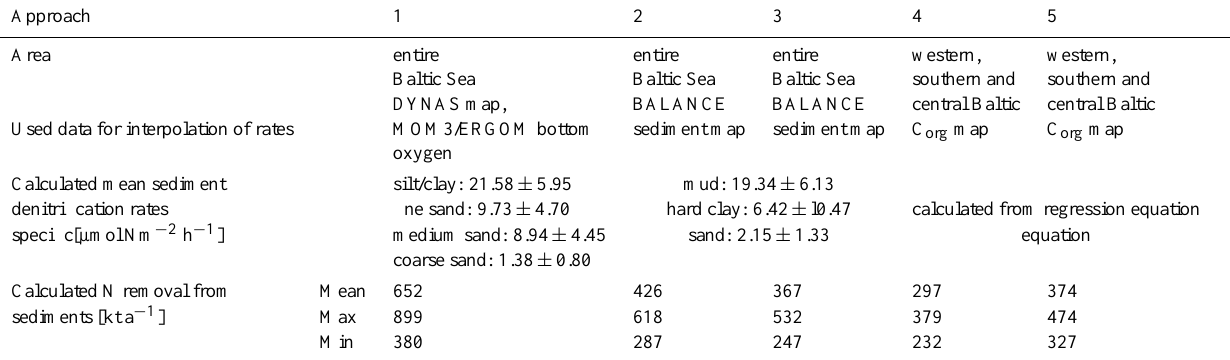
Table 3. Calculated sediment specific denitrification rates as well as calculated mean, maximum, and minimum annual N-removal. Approach